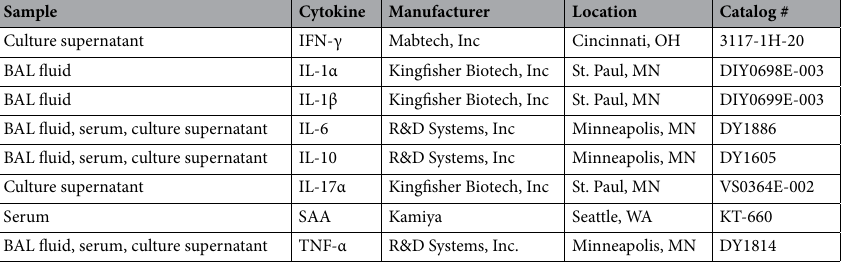
Table 1. ELISA commercial kits and manufacturers used in the study. BAL broncho-alveolar lavage, IFN-γ interferon-gramma, IL-1α interleukin-1 alpha, IL-1β interleukin-1 beta, IL-6 interleukin-6, IL-10 interleukin 10, IL-71α interleukin-17 alpha, SAA serum amyloid A, TNF-α tumor necrosis